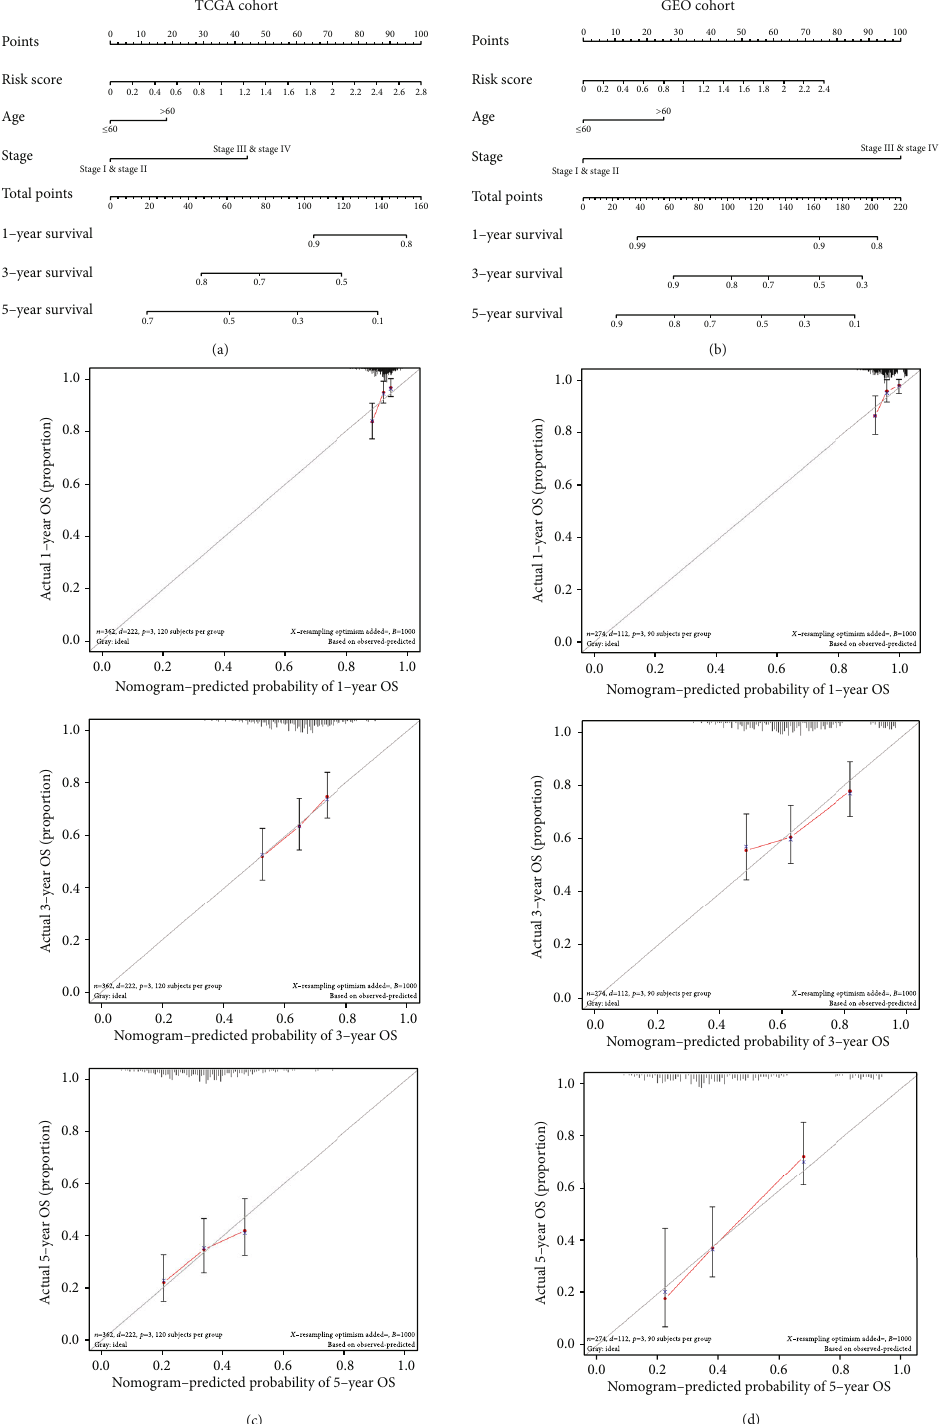
Figure 4: Construction and validation of the nomogram. (a, b) Nomograms of the TCGA and GEO cohorts were used to predict 1-, 3-, and 5-year survival probabilities in OV patients. (c, d) In the TCGA and GEO cohorts, calibration curves of nomograms showed the relationship between predicted and actual